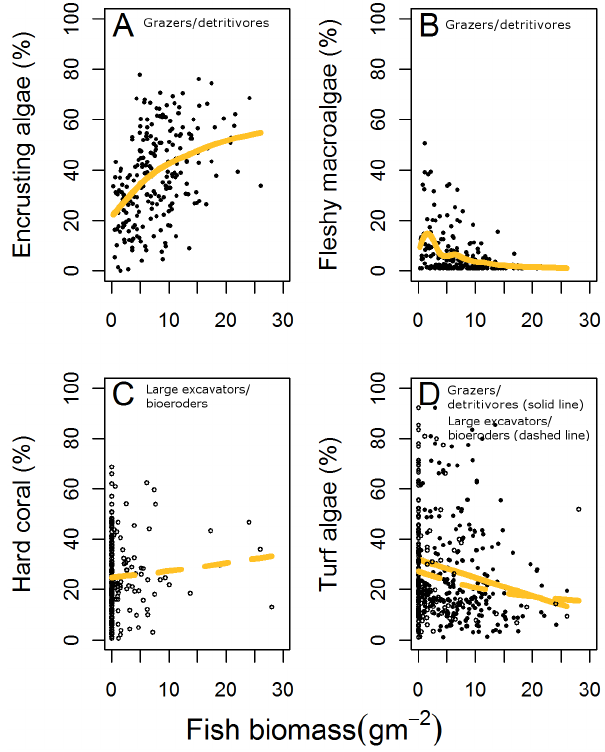
Figure 4. The relationship between the percentage cover of benthic categories with the biomass of herbivorous fish. The best fit relationships identified between (A) encrusting algae and grazers/detritivores (solid points, solid line), (B) fleshy macroalgae and grazers/detritivores (solid points, solid line), (C) hard coral and large excavators/bio-eroders (hollow points, dashed line), and (D) turf algae and grazers/detritivores (solid points, solid line) and large excavators/ bioeroders (hollow points, dashed